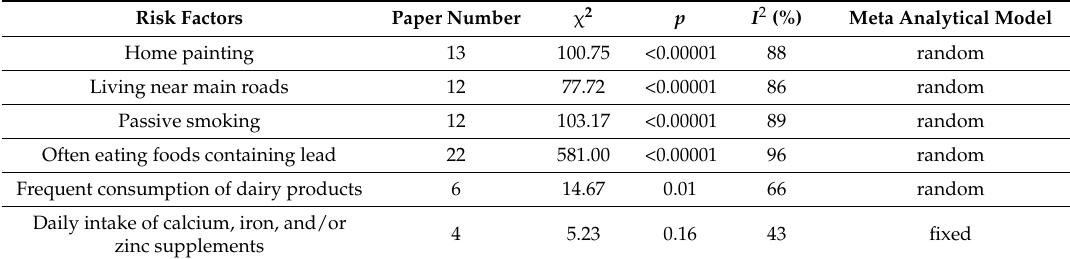
Table 2. Results of heterogeneity test using random-effects and fixed-effects